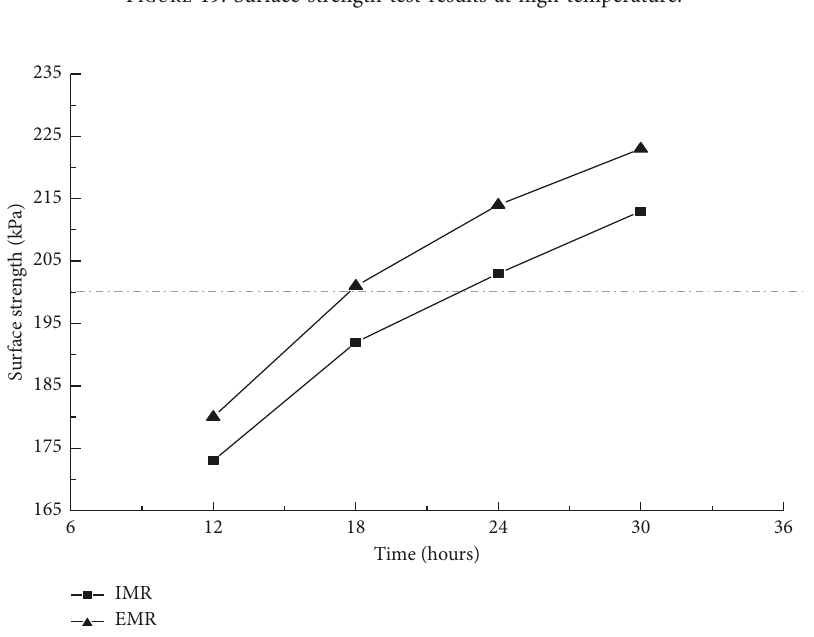
Figure 19: Surface strength test results at high temperature.